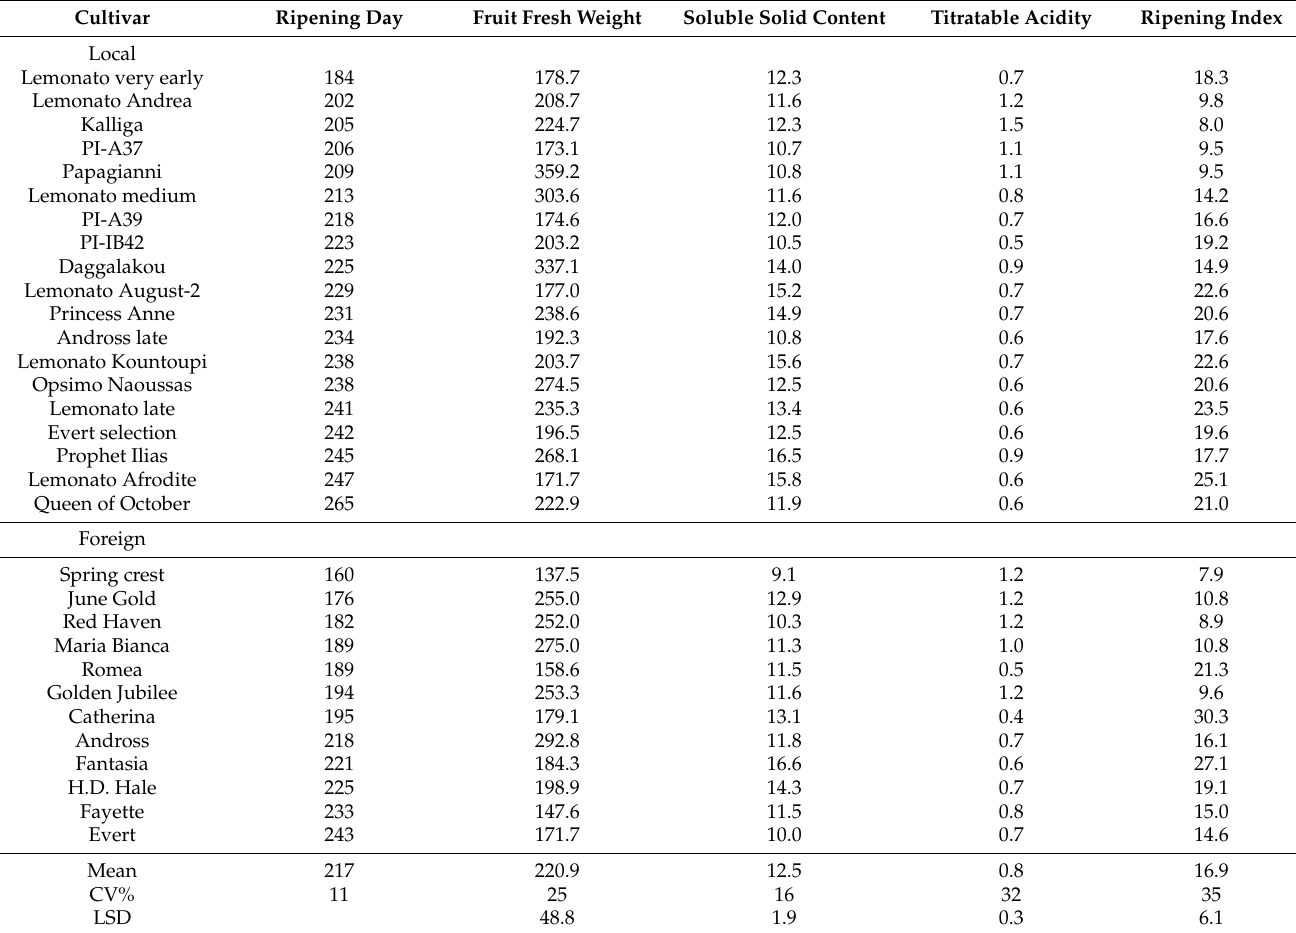
Table 2. Cultivar names, ripening day (Julian day), fruit fresh weight (g), soluble solid content ( ◦ Brix), titratable acidity (g malic acid 100 − 1 mL juice) and ripening index (soluble solid content/titratable acidity) in fruit from 19 local and 12 foreign peach and nectarine cultivars harvested from an ex situ collection at the Department of Deciduous Fruit Trees in Naoussa. Mean values for the local and foreign cultivars are presented. CV%, coefficient variation; LSD, least significant